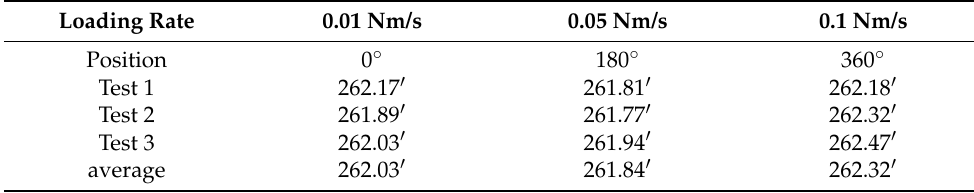
Table 7. Experiment results of δ .